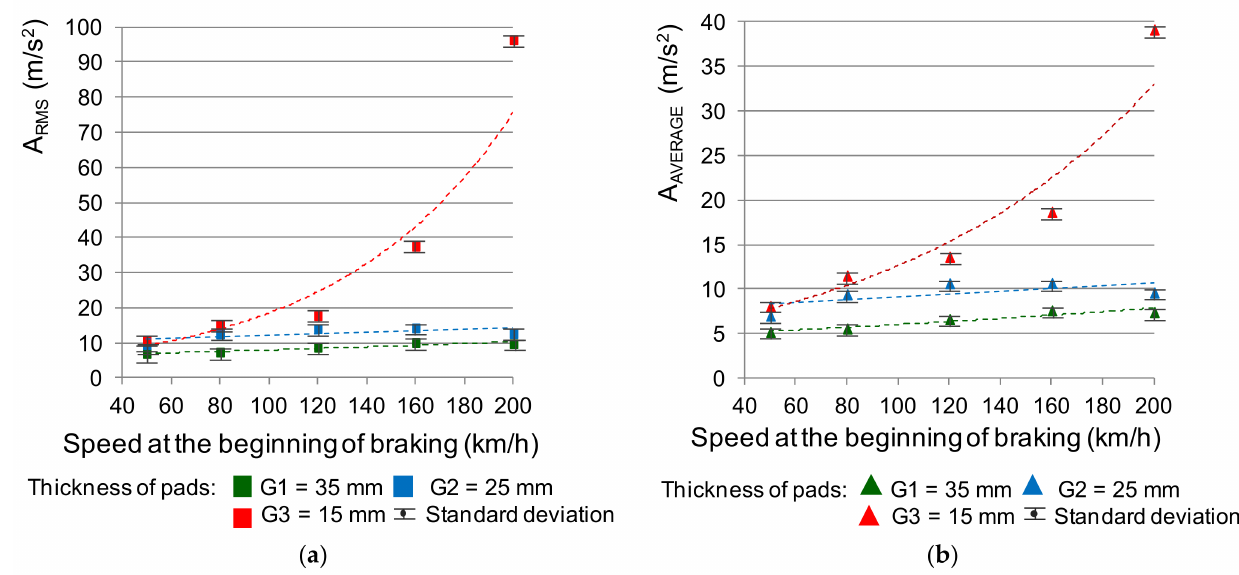
Figure 8. Dependence of the measure of vibration acceleration on the speed at the beginning of braking and the wear of the friction linings: ( a ) A RMS effective value, ( b ) average value A Average